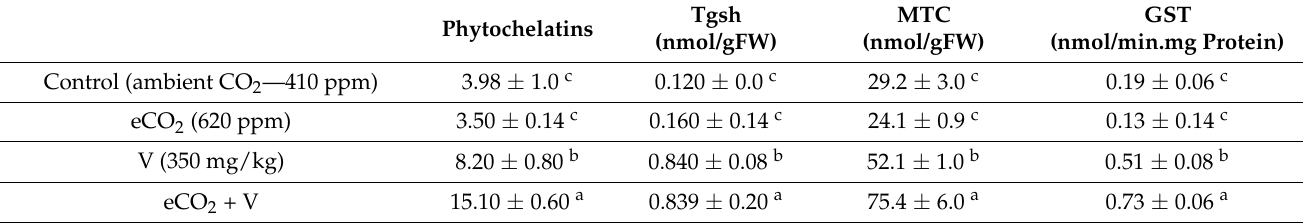
Table 5. Effect of elevated CO 2 (eCO 2 ), vanadium (V) and their combination (eCO 2 + V) on reduced glutathione (GSH), total glutathione (Tgsh), Metallothioneins (MTC) and glutathione-S-transferase (GST). Data are mean values ± SE ( n = 4). Using Fisher’s LSD test, the data for each group were compared pairwise ( p < 0.05; n = 4). Different letters indicate that there is a significant difference between the